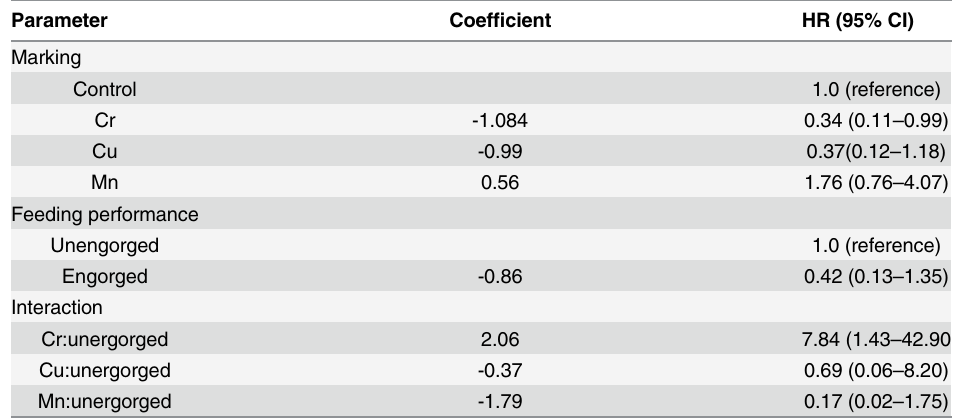
Table 4. Associations between Triatoma pseudomaculata trace element marking and feeding perfor- mance or